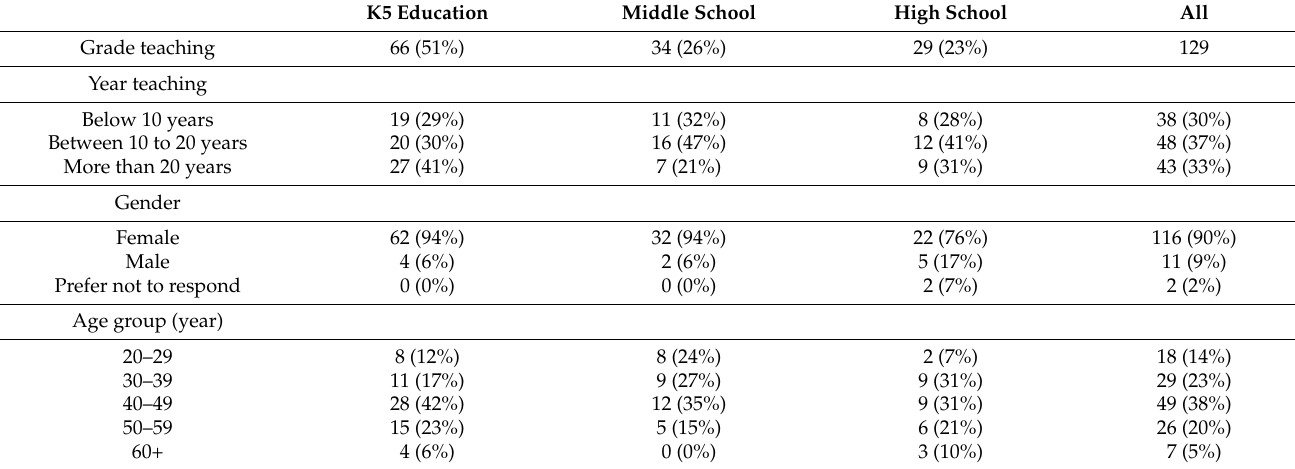
Table 1. Baseline characteristics of